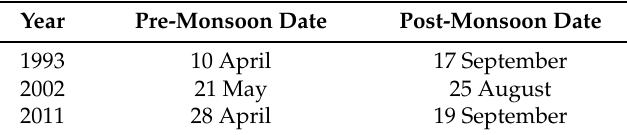
Table 1. Dates of the Landsat TM Scenes selected by